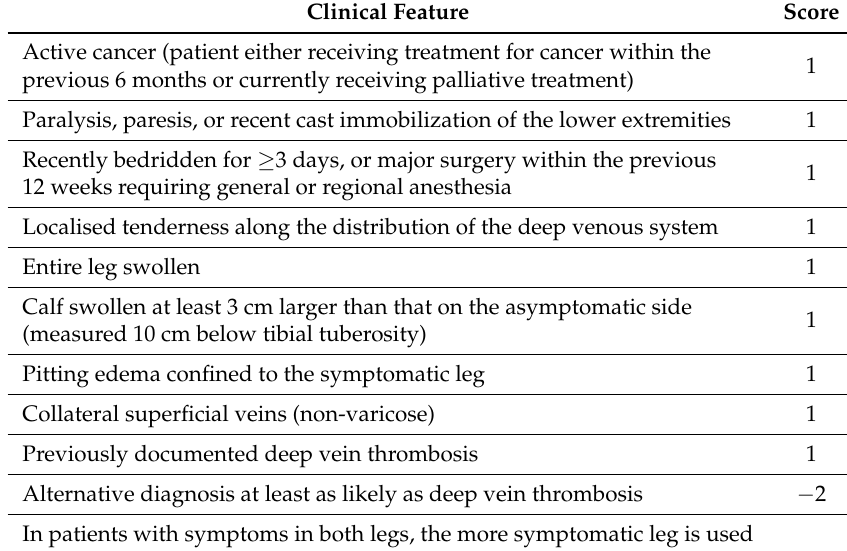
Table 1. Wells criteria for the prediction of deep vein thrombosis (DVT) [18,60,65]. Clinical Feature